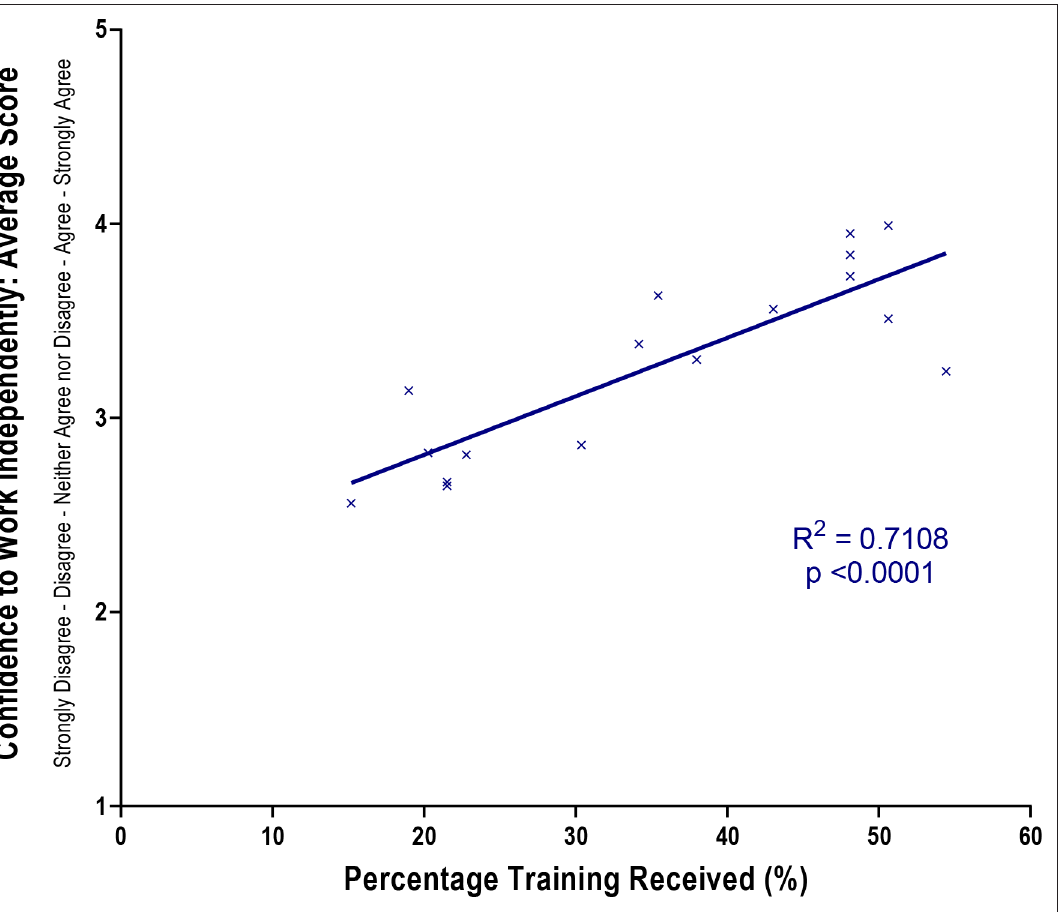
Figure 2 Relationship between percentage training received and the confidence to work independently for telephone